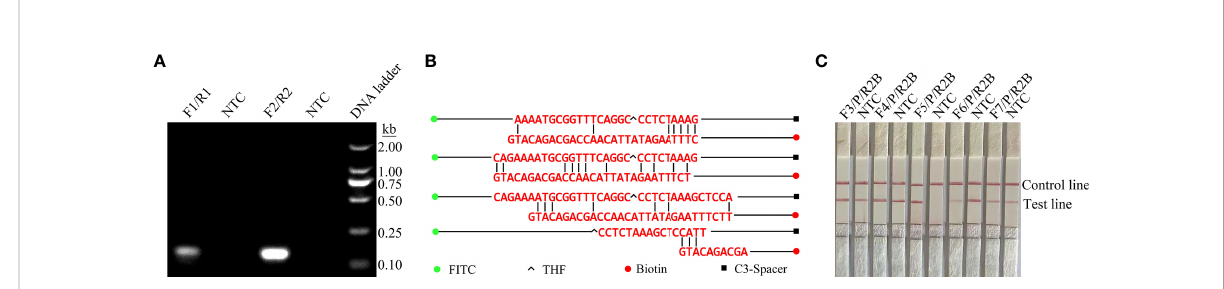
FIGURE 1 Screening of primer-probe combinations. (A) RPA results for two different primer sets against ITS2. The name of each primer set is shown at the top of each lane. NTC indicates the template-free control for the respective primer pair. All reactions were performed at 37°C for 20 min. The images represent the results of three independent experiments. (B) Pairwise analysis and sequence modi fi cation of the primer-probe set were used to design the ITS2 primers with Primer Premier 5 software, and assess the associated DNA base substitutions of the probes and primers. The DNA strands are shown as horizontal lines, and the matching bases are indicated by vertical lines. Molecular markers are listed in Figure (B) . (C) Validity of primer-probe sets for the RPA-LFS assay. The name of each primer set is shown at the top of each lane. NTC indicates the no- template control for the respective primer pair. The positions of the test and control lines are shown on the right. All reactions were performed at 37°C for 20 min. The images represent the results of three independent experiments.